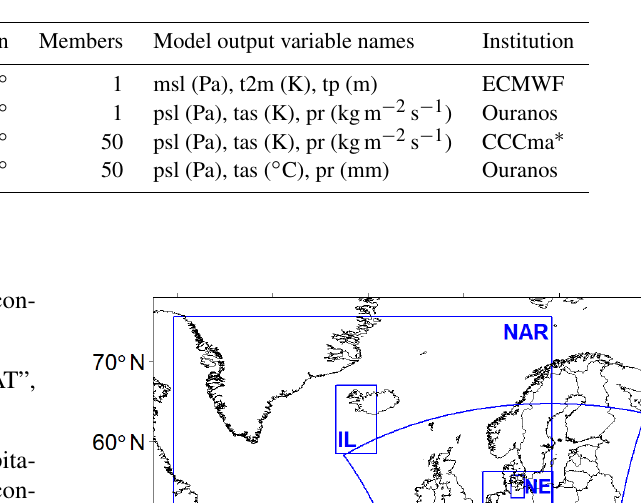
Table 1. Overview of used data sets, their spatial resolution, the number of members and the employed variables.